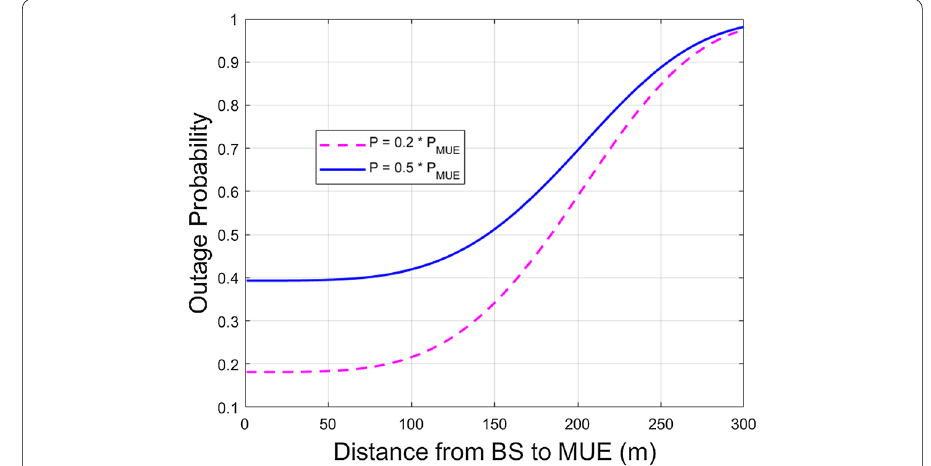
Fig. 6 Outage probability vs. distance from BS to MUE in downlink